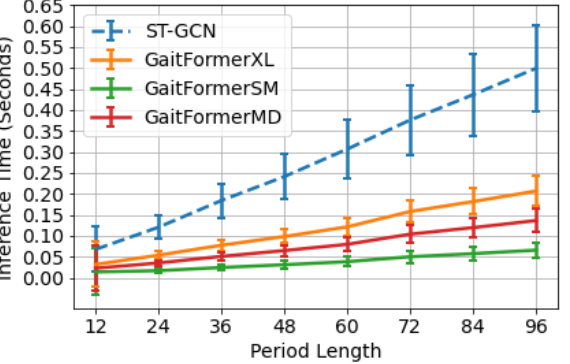
Figure 9. Inference times across processed walking duration length (period length) for ST-GCN and the various sizes of GaitFormer. We report the mean and stardard deviation across 100 runs, for each period